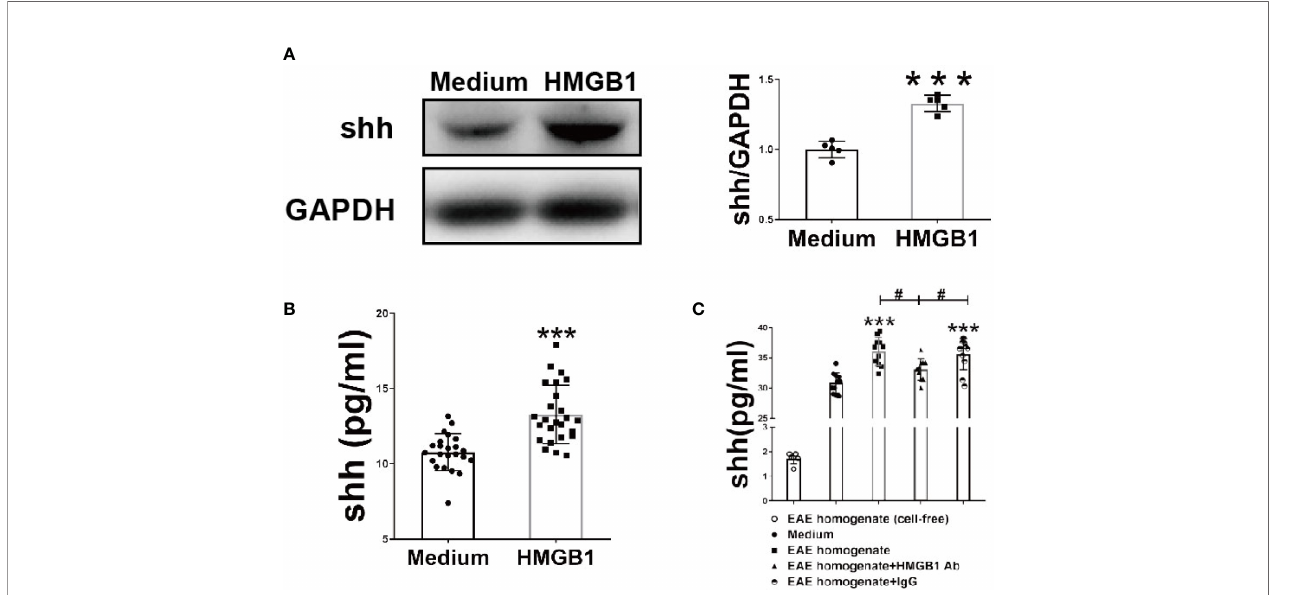
FIGURE 1 | The effect of HMGB1 on expression and release of shh in astrocytes. (A) The protein from astrocytes was obtained and detected by western blot (1 m g/ ml recombinant HMGB1 was used). (B) The level of shh in supernatant from astrocytes after recombinant HMGB1 (1 m g/ml) or (C) brain homogenate of EAE onset stage (100 m g/ml) with/without HMGB1 Ab/IgG (5 m g/ml) stimulation for 24h were detected by ELISA. EAE homogenate (cell-free) group here indicates interstitial fl uid (100 m g/ml) from the onset stage of EAE mice without cultured astrocytes. All the data are shown as mean ± SD (*** P < 0.001 compared with medium; # P < 0.05 compared with each